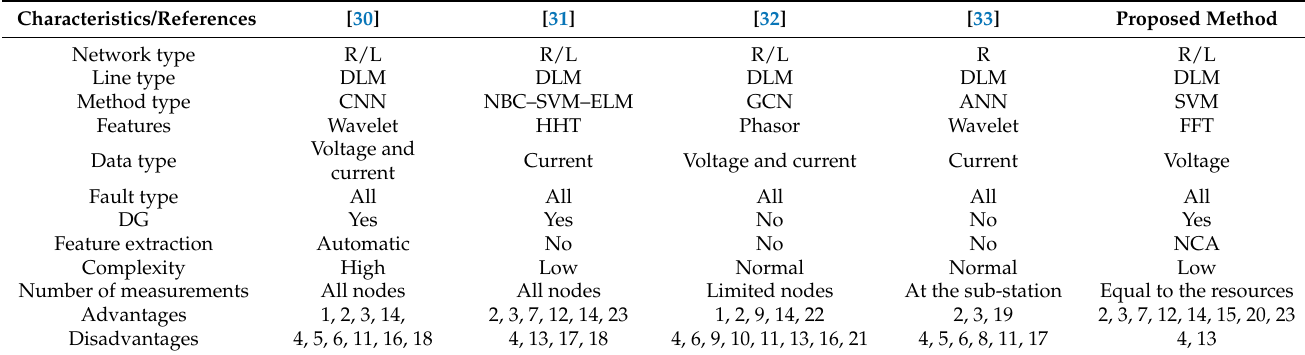
Table 1. The comparison of the